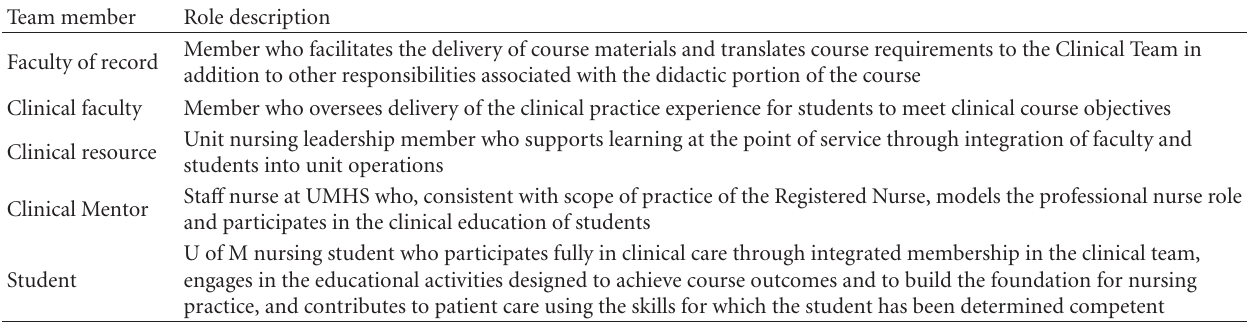
Table 1: Clinical team teaching